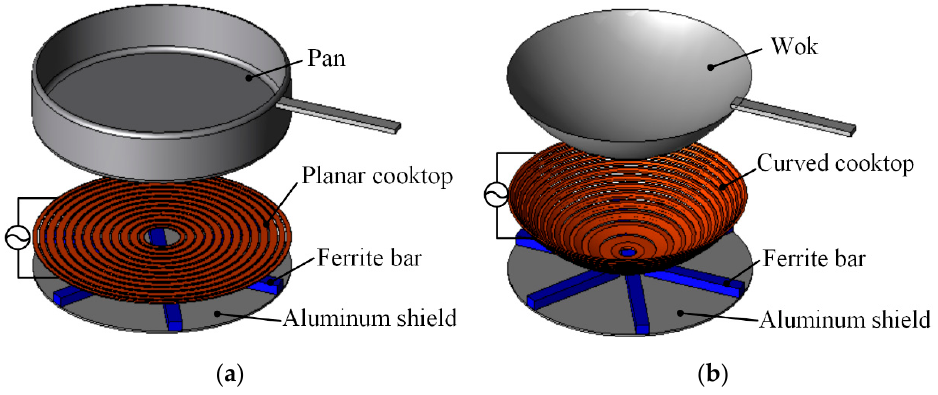
Figure 1. Existing induction heating systems. ( a ) Planar cooktop. ( b ) Curved cooktop.